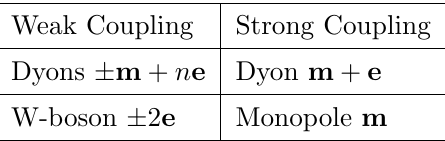
Table 1. BPS spectrum of pure N = 2